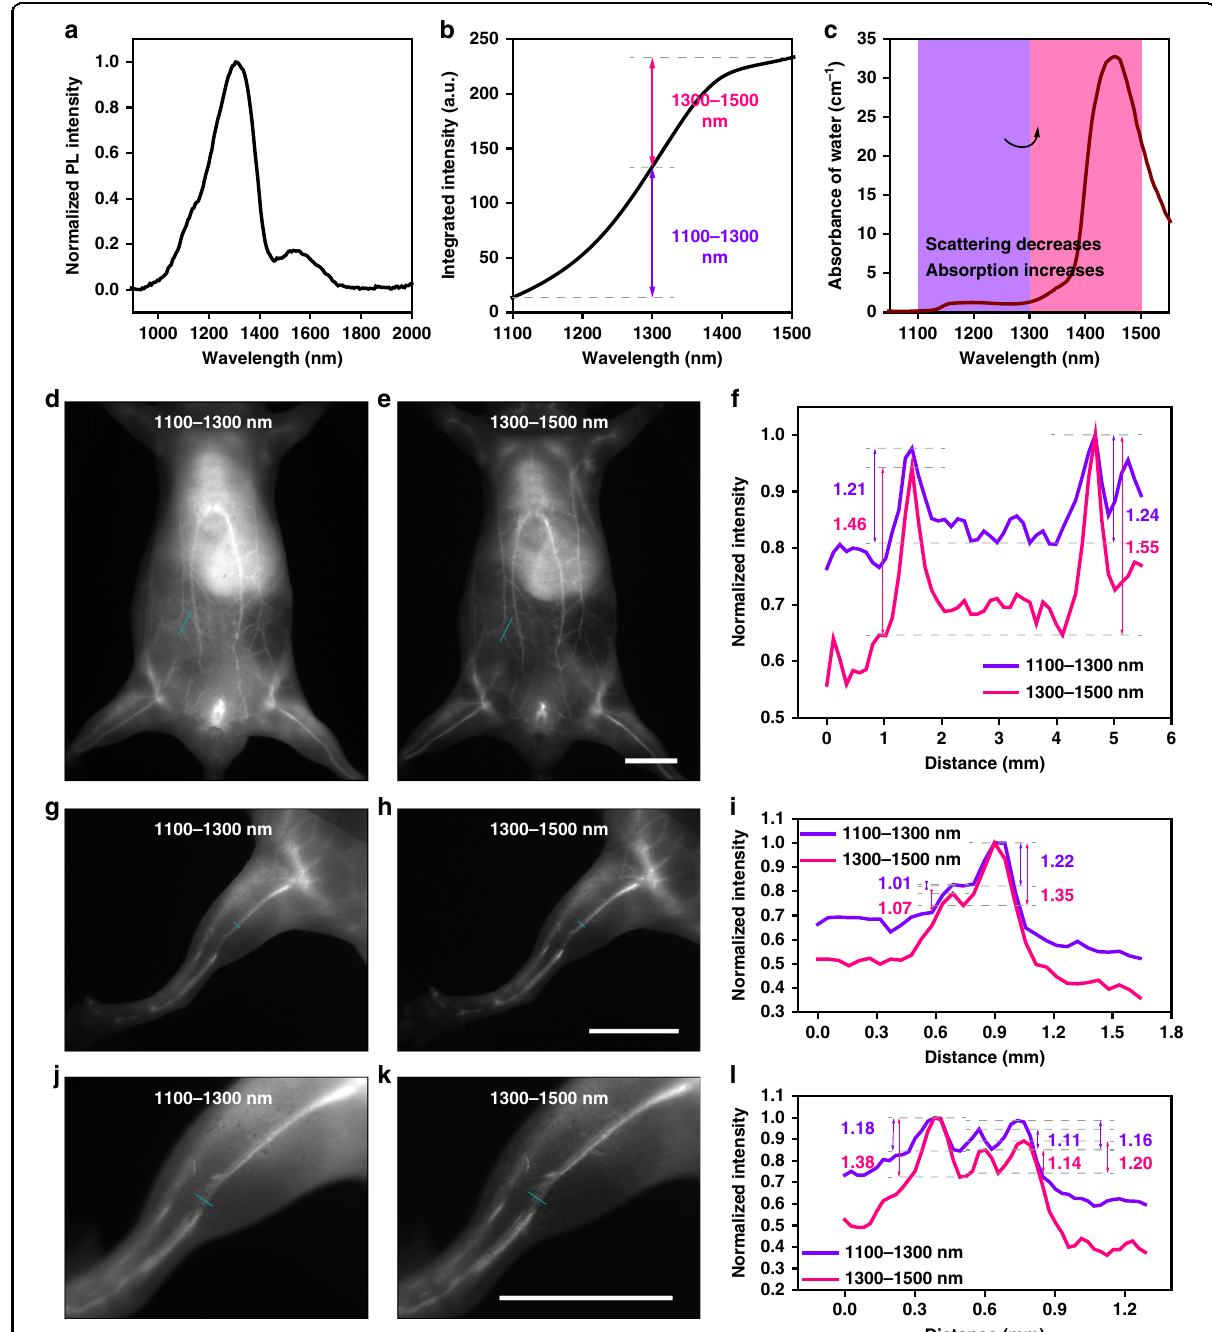
Fig. 4 Comparison of in vivo fl uorescence imaging of mice in 1100 – 1300 and 1300 – 1500nm. a The emission spectrum of PEGylated 1300- PbS/CdS QDs in water. b The integrated emission intensity of PEGylated 1300-PbS/CdS QDs in water. The value difference on the ordinate represents the total emission intensity in the corresponding spectral (abscissa) range. c The absorbance of water within 1000 – 1600 nm 38 . The whole-body imaging of the same mouse in ( d ) 1100 – 1300 nm and ( e ) 1300 – 1500 nm. f Cross-sectional fl uorescence intensity pro fi les along the indigo lines of the blood vessel in ( d , e ). The numbers show the SBRs. The hind limb imaging of the same mouse in ( g ) 1100 – 1300 nm and ( h ) 1300 – 1500 nm. i Cross- sectional fl uorescence intensity pro fi les along the indigo lines of the blood vessel in ( g , h ). The numbers show the SBRs. The hind limb imaging of the same mouse at a larger magni fi cation in ( j ) 1100 – 1300 nm and ( k ) 1300 – 1500 nm. l Cross-sectional fl uorescence intensity pro fi les along the indigo lines of the blood vessel in ( j , k ). The numbers show the SBRs. Scale bars: 10